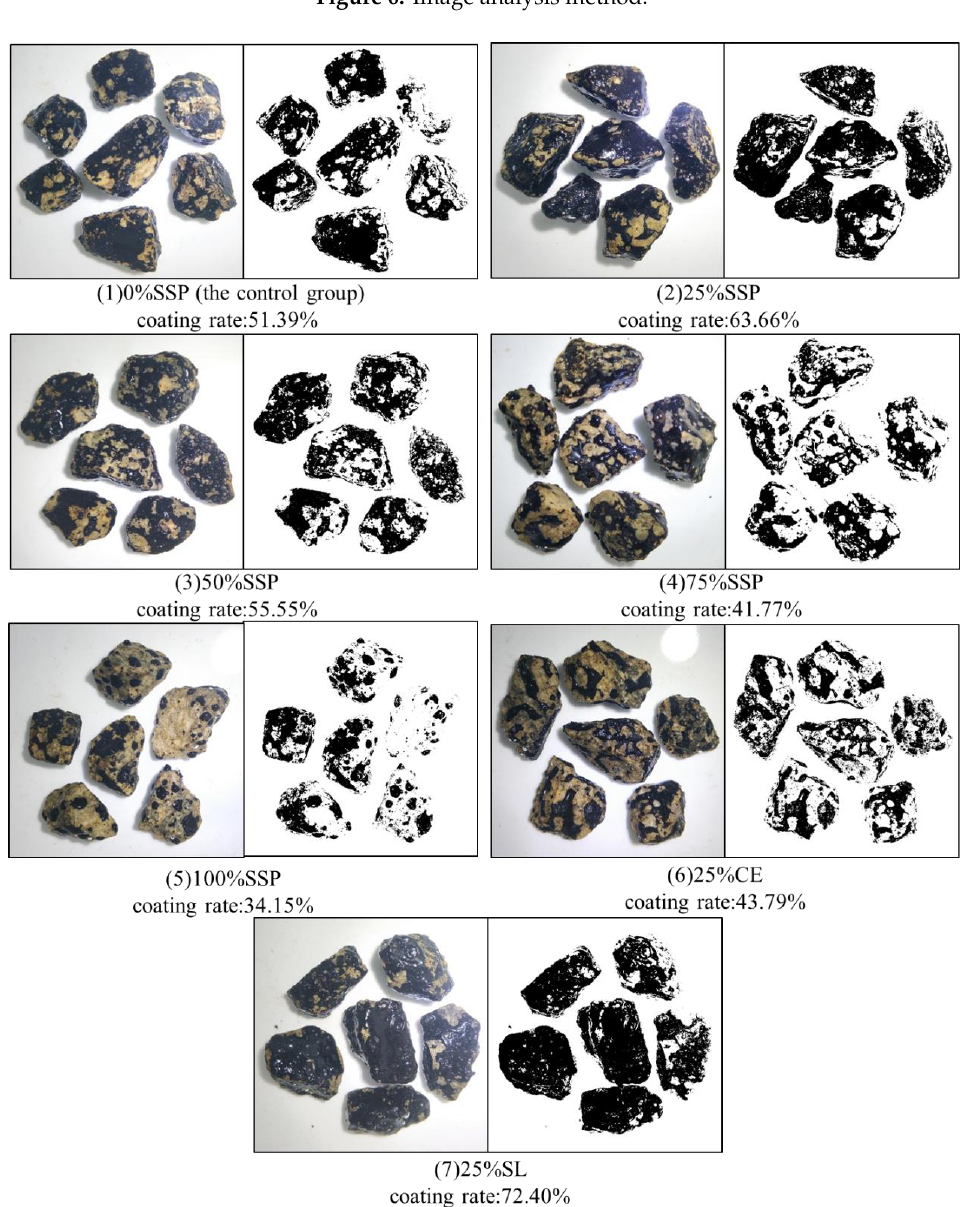
Figure 7. Image processing results and asphalt coverage rate.